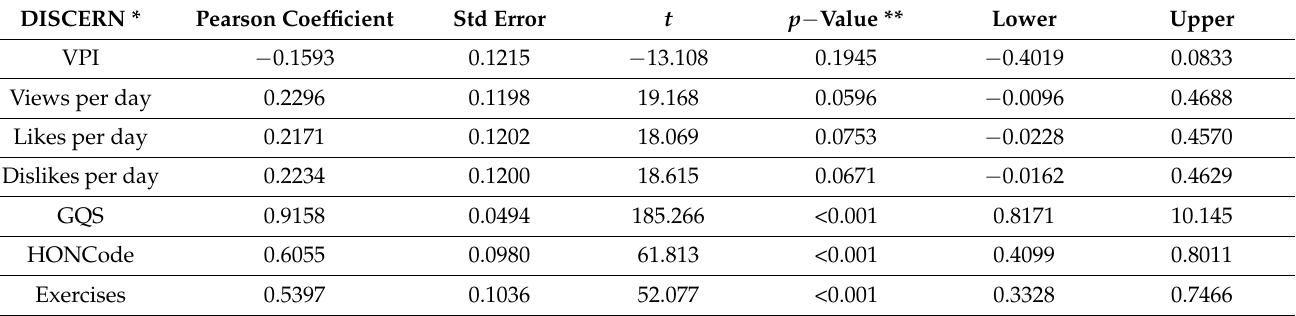
Table 2. Coefficients of Pearson’s correlations of each variable’s referred to DISCERN score.